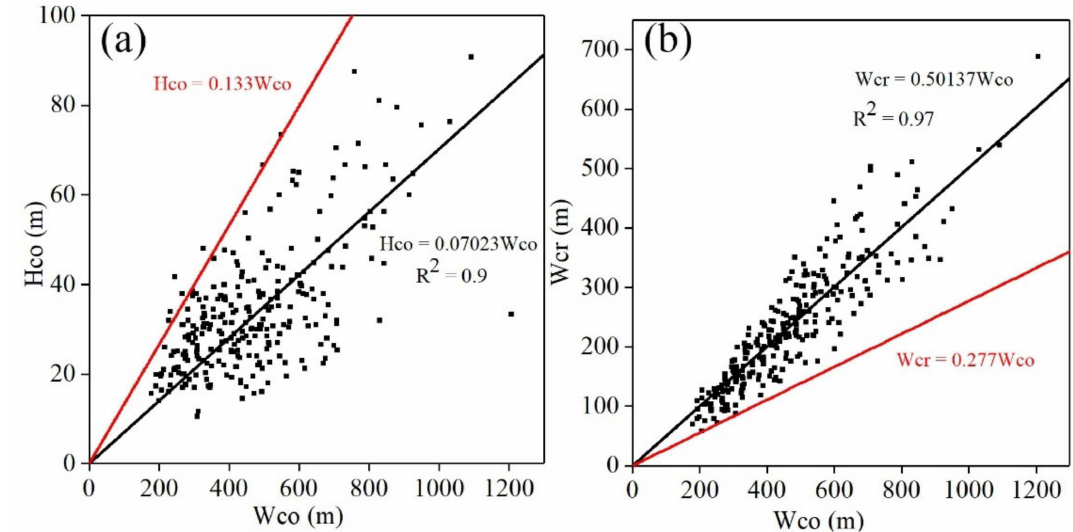
Figure 10. The linear regression relationships of the three parameters. ( a ) Plot of cone height (Hco) versus cone basal diameter (Wco) for the 272 cones. ( b ) Plot of cone crater width (Wcr) versus cone basal diameter (Wco) for the 272 cones. Black lines represent the best fit (linear regression). Red lines represent the best fit from